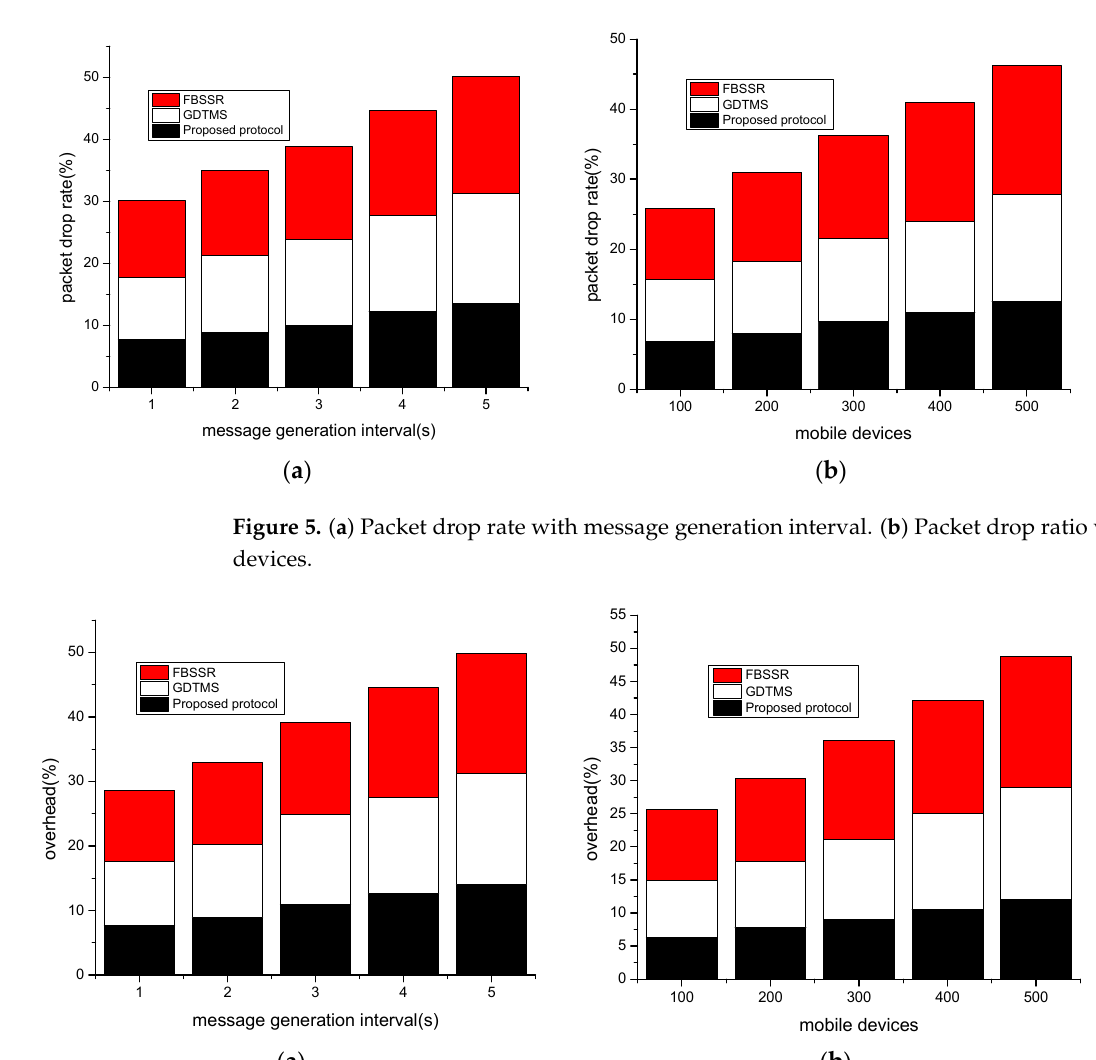
Figure 4. ( a ) Network throughput with message generation interval. ( b ) Network throughput with mobile devices.